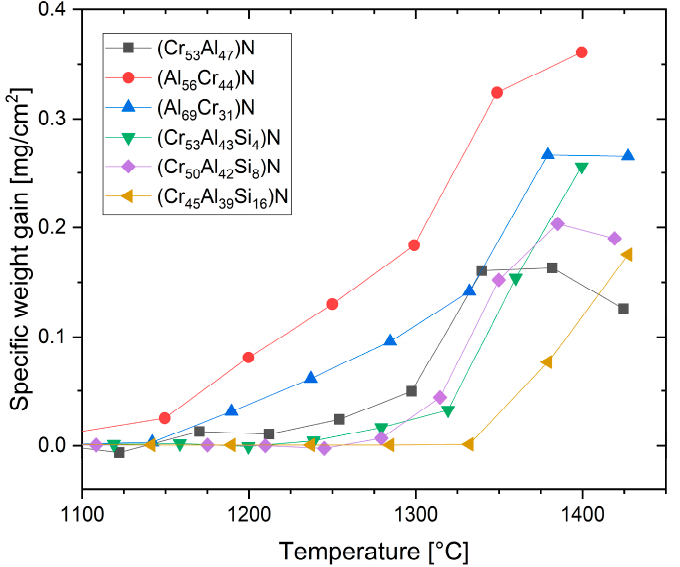
Figure 21. Weight gain measured by dynamic TGA measurements of fcc-structured (AlCr)N, (Al- CrSi)N and (CrAl)N, (CrAlSi)N coatings up to 1440 ◦ C in synthetic air, redrawn after [119], original © American Vacuum